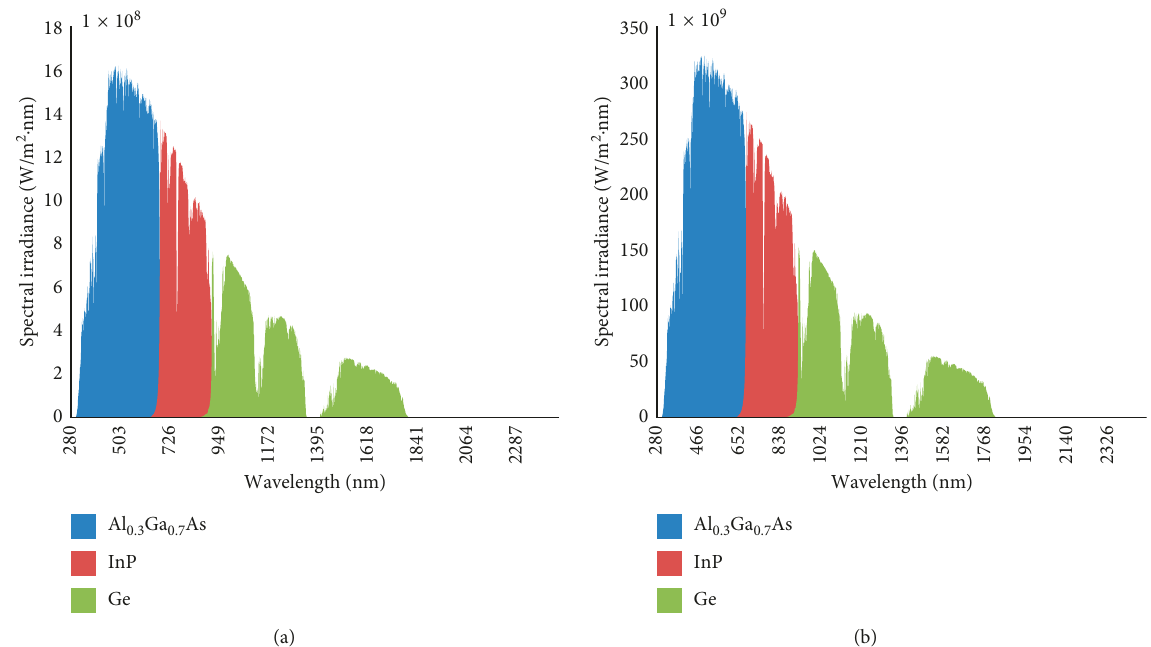
1 (1 sun) and (b) SIMF 200 (200 suns). (cid:31) (cid:31)